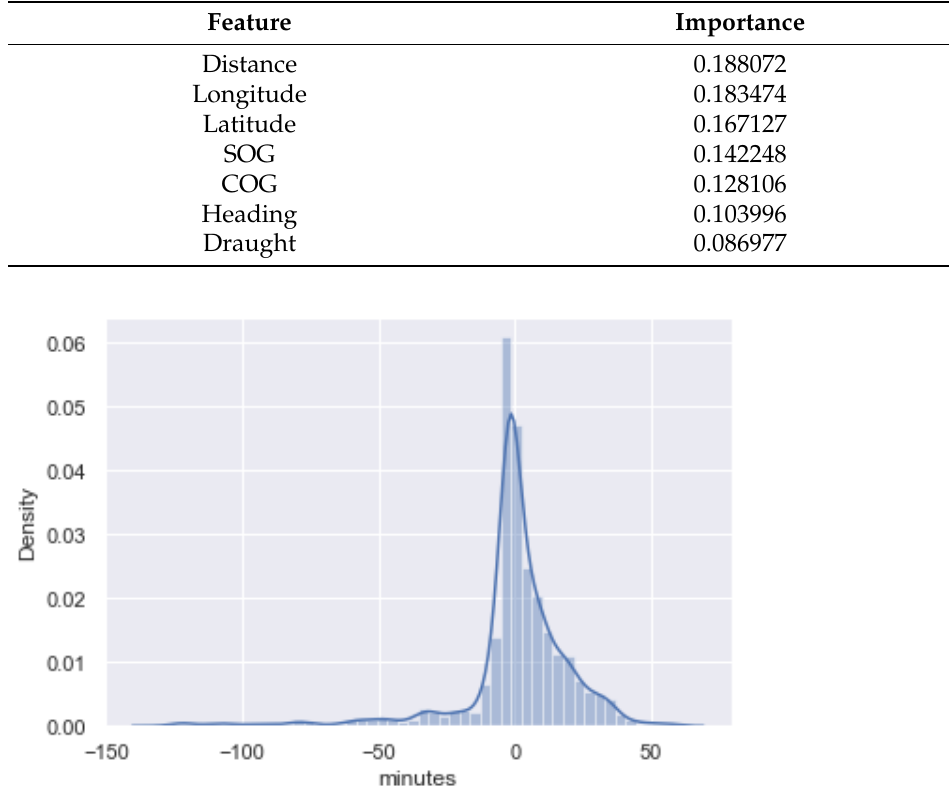
Table 1. Features used in the best performing model and their importance.